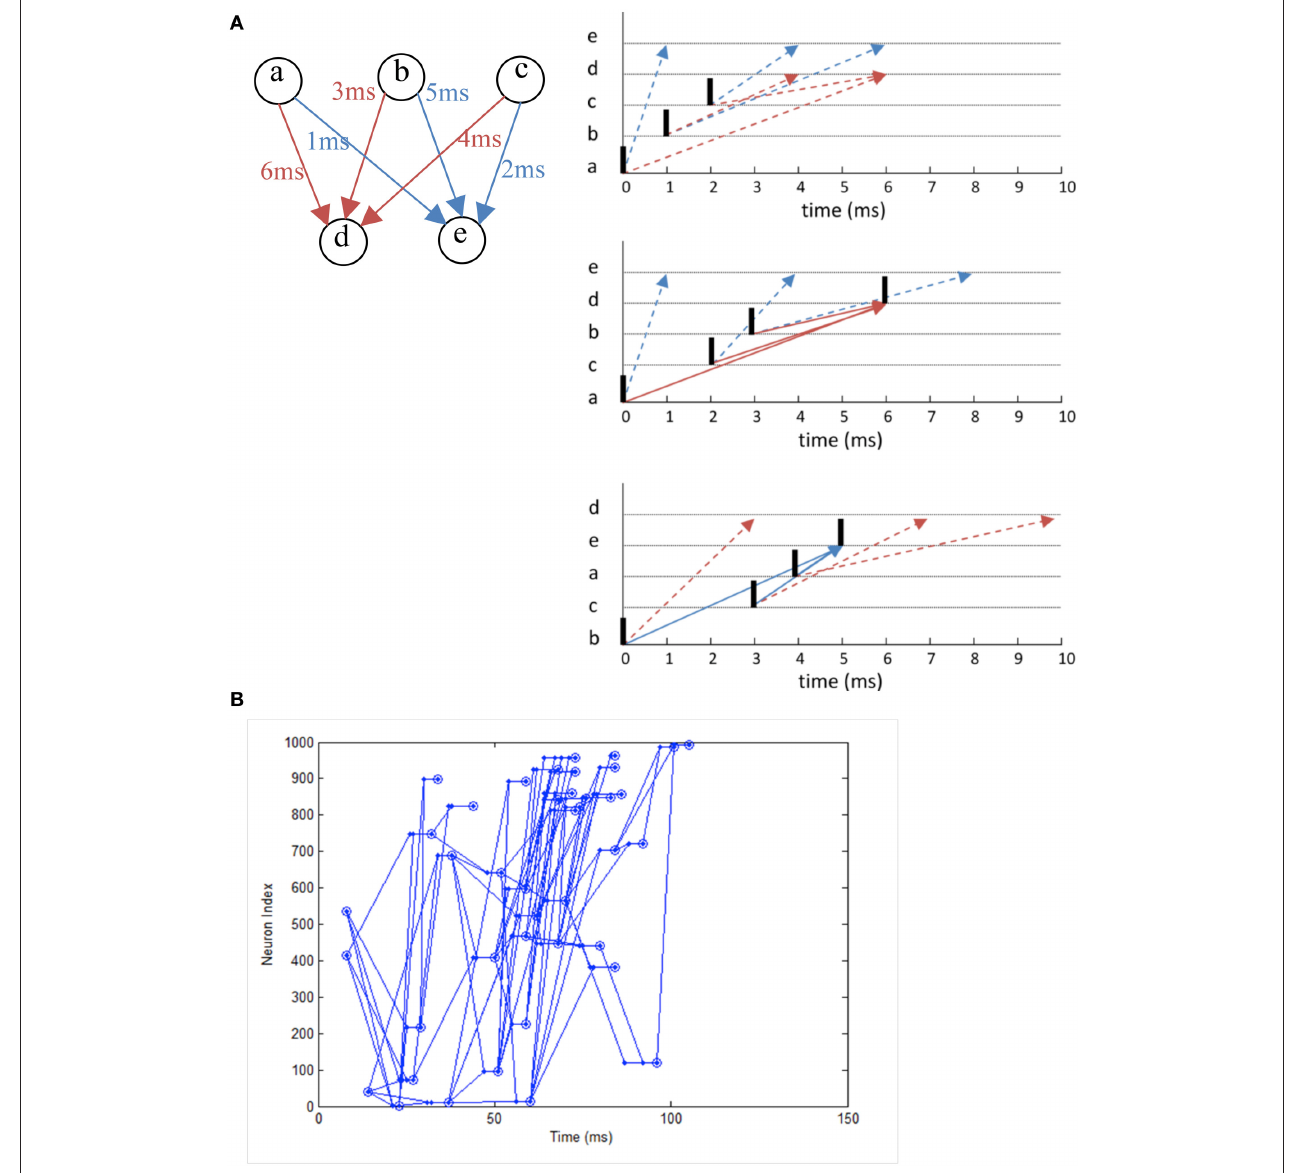
FIGURE 12 | (A) The working principle of polychronization. Izhikevich (2006) proposed this mechanism, which shows that the various spike conductance delay can produce time-locked spiking patterns which are triggered by certain initial activation pattern. The pattern occurs spontaneously during long simulations of network with STDP. The dotted line represents the propagation of spikes in the network. (B) Polychronous network simulated produces a number of time-locked patterns upon activation of certain